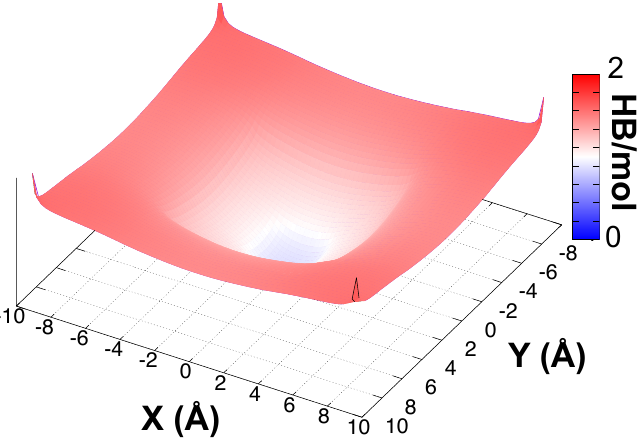
Figure 6. Time-averaged spatial resolution of the number of intra-2DN HBs (between two water molecules both belonging to the 2DN) per water molecule in the 2DN in each (x;y) point of a grid. The xy plane is oriented parallel to the surface and the (0;0) point is the projection of the hydronium position on the xy